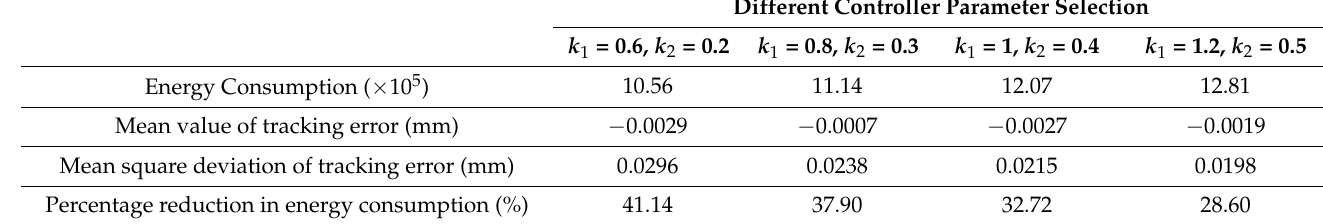
Table 3. Energy consumption, mean value of tracking error, mean square deviation of tracking error, and percentage reduction of energy consumption compared with the traditional scheme under different controller parameter selection.